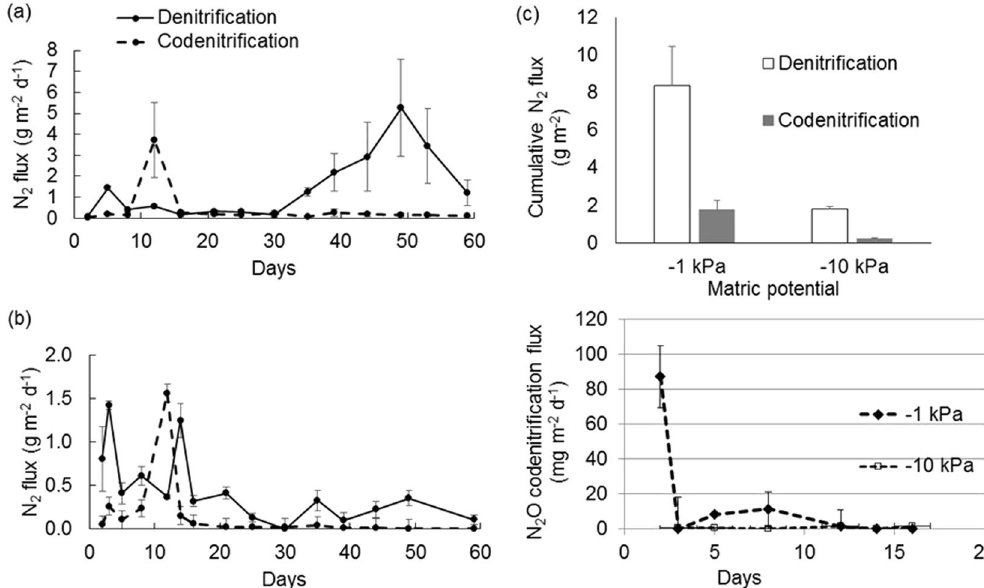
Figure 8. Denitrification and codenitrification fluxes over time. The codenitrification and denitrification fluxes, over time since 15 N urea addition, are shown as daily N 2 fluxes for ( a ) soil at − 1 kPa ( b ) soil at − 10 kPa and ( c ) as cumulative codenitrification and denitrification N 2 fluxes, while ( d ) is the N 2 O codenitrification flux, over time since 15 N urea addition, as daily N 2 O fluxes. Symbols are means (n = 4) with vertical error bars the standard error of the